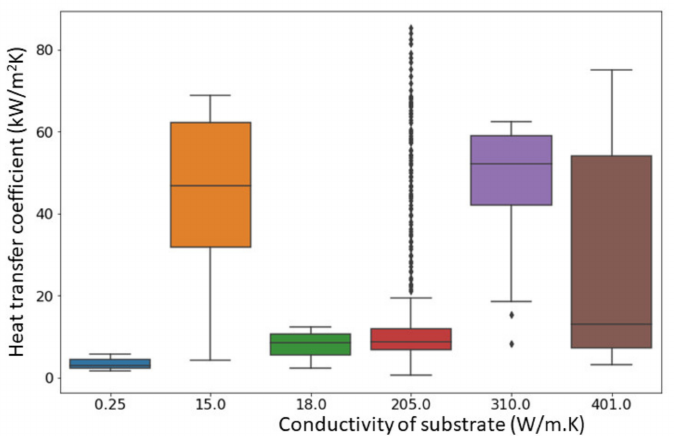
Figure 2. Heat transfer coefficient vs. thermal conductivity of substrate material.